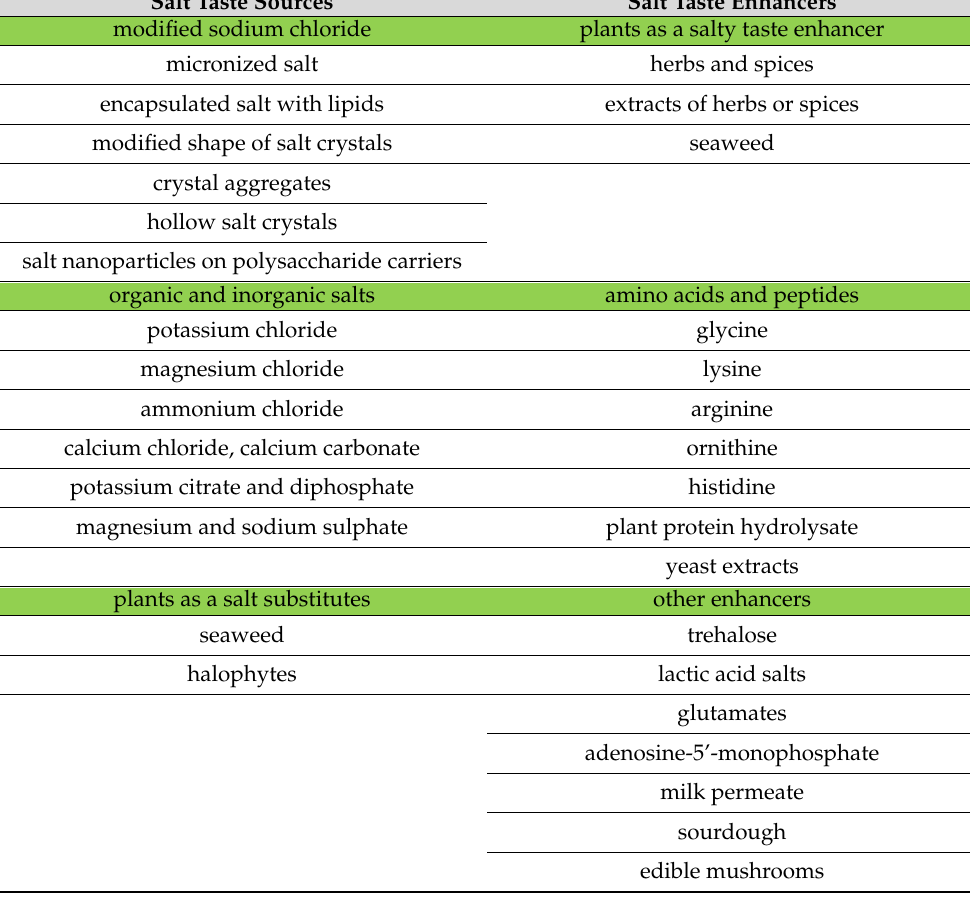
Table 2. The overview of materials applicable as salt substitutes and salt enhancers, created by